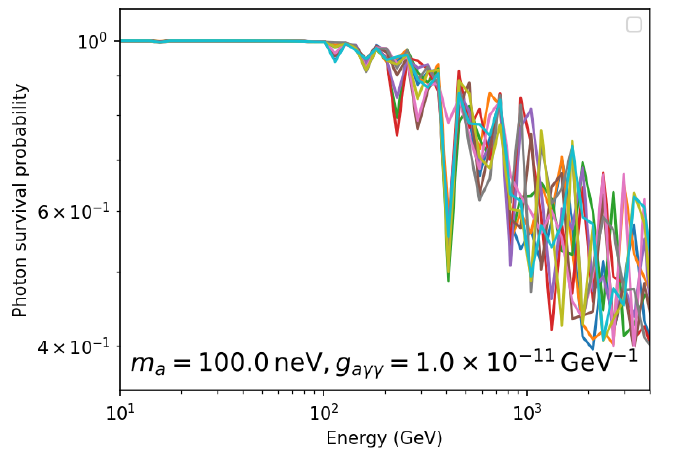
10 − 11 GeV − 1 . Obtained using ×